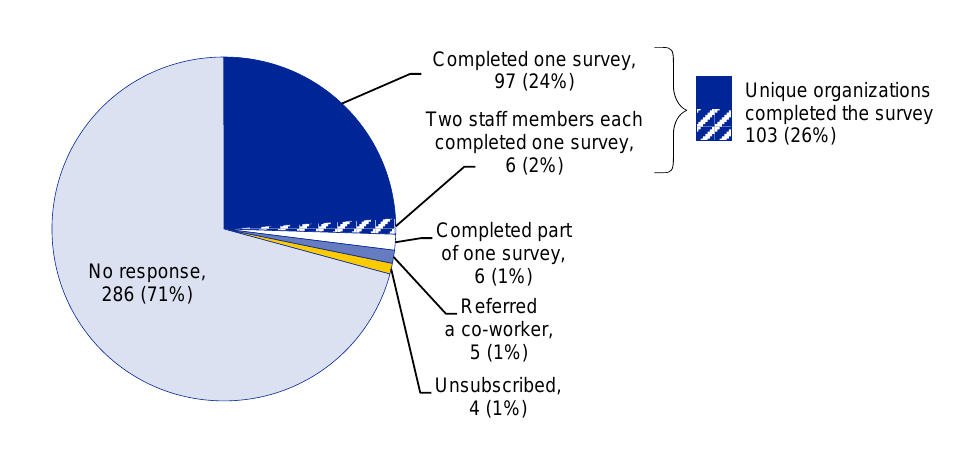
Figure 1. Among the 398 organizations that were emailed at least one survey invitation for which we did not receive an “undeliverable” response, the number and percentage falling into each response status